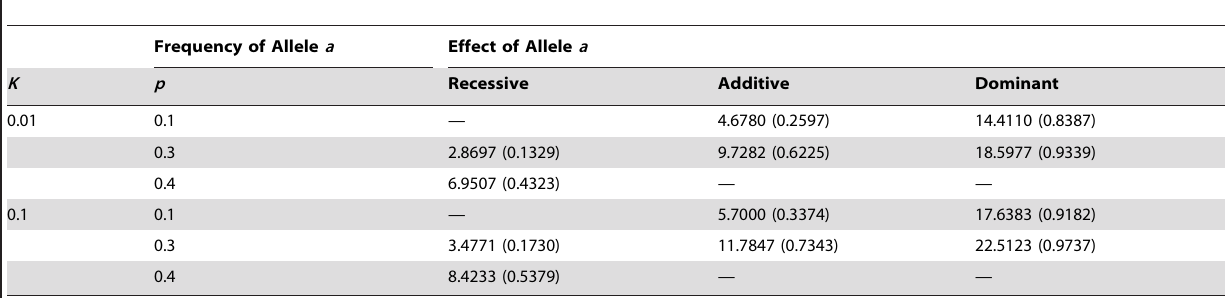
Table 1. Non-centrality value and the associated power (presented in parentheses) for models used in the simulation studies.